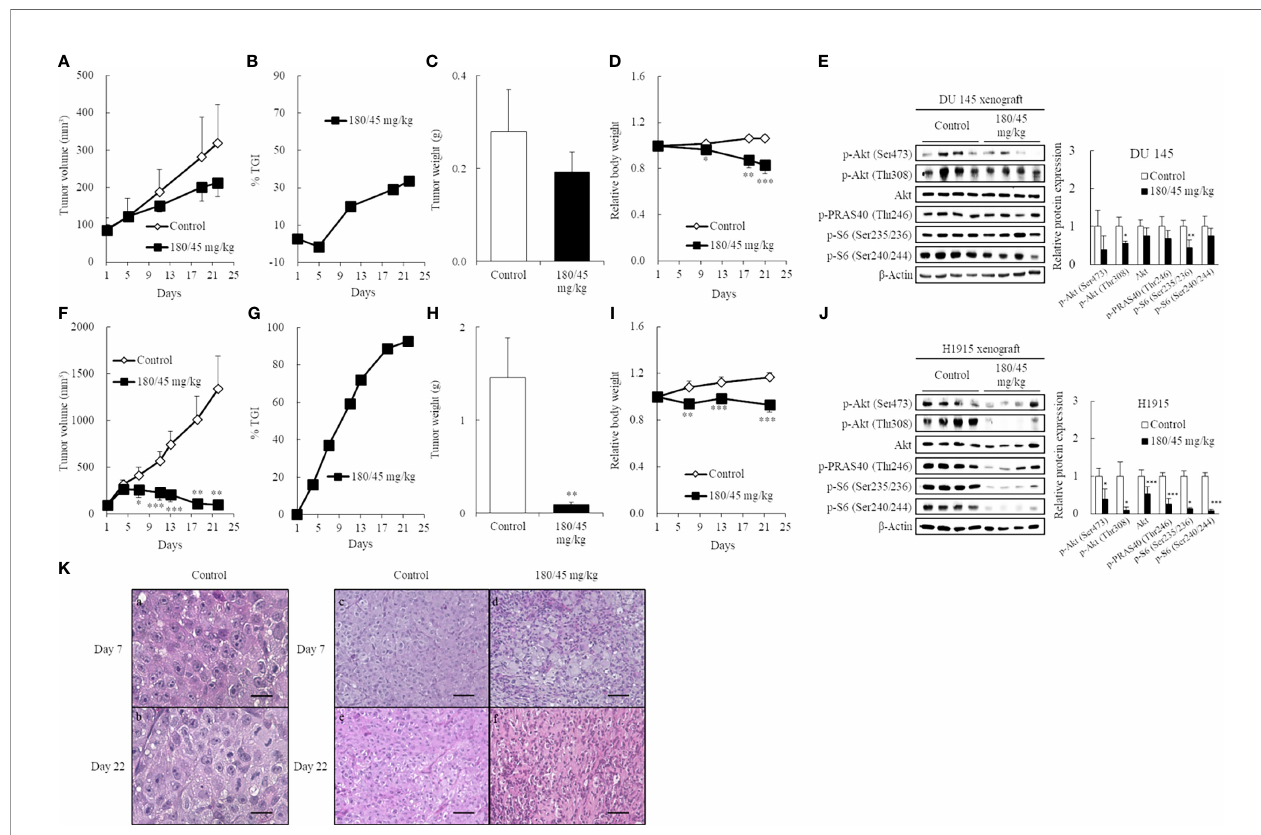
FIGURE 4 | Induction of high antitumor ef fi cacy against ectopic H1915 xenografts in association with blockade of the PI3K/Akt pathway by perifosine. Mice bearing subcutaneous DU 145 (A-E) and H1915 (F-J) tumors were randomized on day 1 and treated orally with either vehicle or perifosine using a 5-day-on/2-day-off × 3 cycle schedule (n = 5). On day 22, xenograft tumors were excised 4 h following the last dose. Changes in TV (A, F) , tumor growth inhibition rate (TGI, %) at different days (B, G) , tumor weight (C, H) , and relative body weight (D, I) . The expression level of key molecules was detected by western blot on Day 22 (E, J) . Images are representative of at least two independent experiments with similar results. b -actin was used as a loading control. Protein levels were quanti fi ed and represented as the percentage of the control group. * p < 0.05; ** p < 0.01; *** p < 0.001 versus the control group. (K) Representative H&E images of the H1915-tumor tissues treated with vehicle (a-c, e) and perifosine (d, f) on days 7 and 22 are shown; scale bar = 20 m m (a, b) or 50 m m (c-f) . High-power views in the control group suggest that the tumor cells are large, round-to-oval, and possessed distinct multiple nucleoli in the clear oval nucleus (a , b)